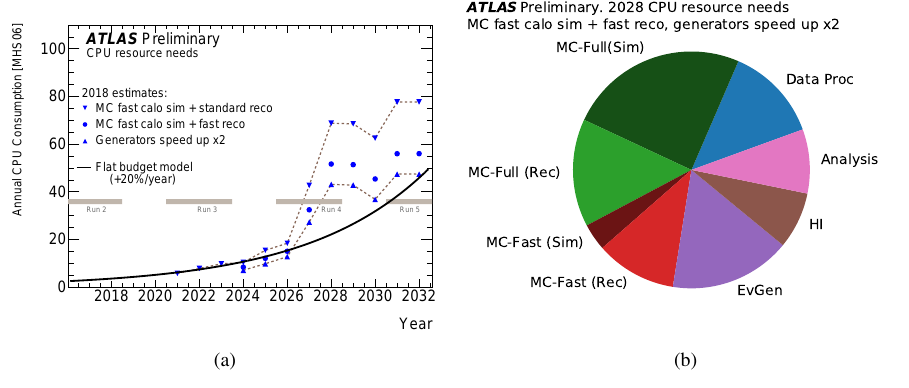
Figure 1: (a) Estimated CPU resources (in MHS06) needed for the years 2018 to 2032 for both data and simulation processing. The blue points show the improvements possible in three di ff erent scenarios, which require significant development work: (1) top curve with fast calo sim used for 75% of the Monte Carlo simulation; (2) middle curve using in addition a faster version of reconstruction; (3) bottom curve, where the time spent in event generation is halved. The solid line shows the amount of resources expected to be available if a flat funding scenario. (b) Fraction of CPU resources needed in 2028 at the end of Run 4 for di ff erent pro- cessing workflows. The ‘MC-Full’ section in green is related to the fraction of time spent on the full Atlas Geant4 simulation and divided in a simulation part ‘(Sim)’ for the Geant4 sim- ulation and a reconstruction part ‘(Rec)’ accounting the time spent reconstructing the events.